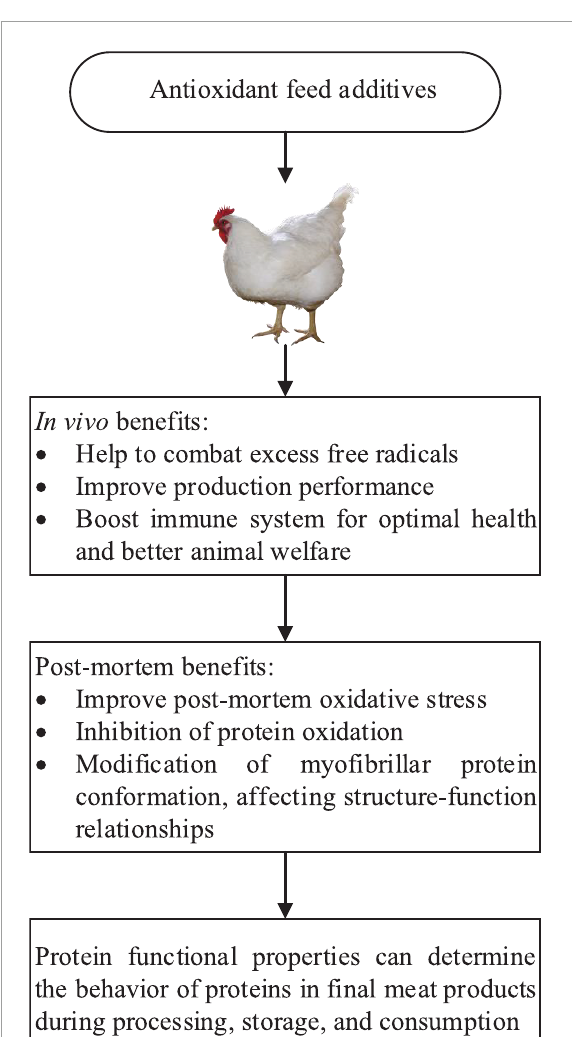
FIGURE1 Schematic concept of post-mortem benefits of antioxidants in